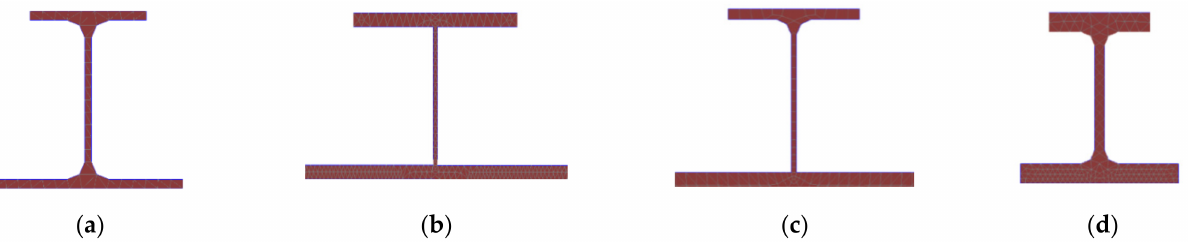
Figure 3. Asymmetric double-T steel cross sections as slim floor beams: ( a ) ASB; ( b ) welded; ( c ) IFB; ( d )